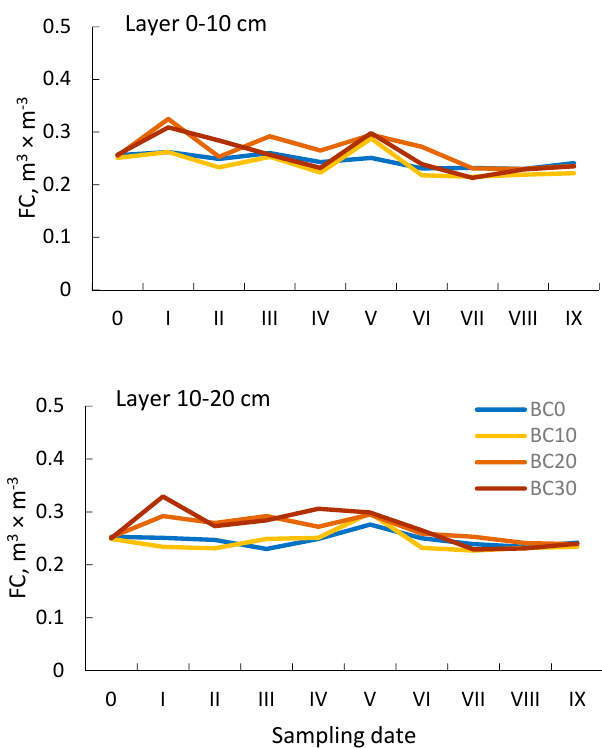
Figure 7. Field water capacity at the potential − 15.5 kPa (FC). Explanations as for Figure 1.